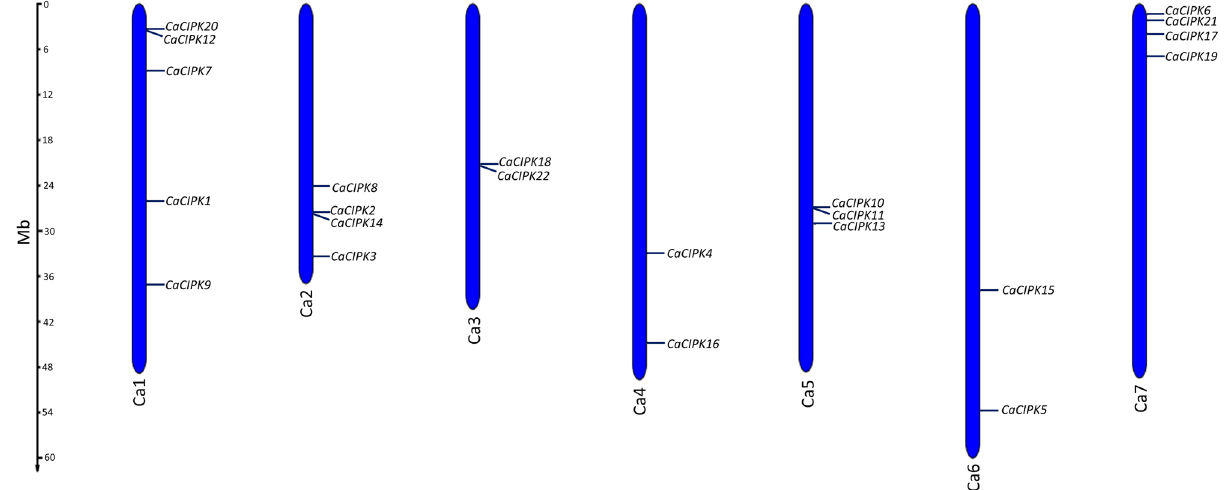
Figure 3. Chromosomal locations of chickpea CIPK genes. Blue colour bars represent the chromosomes, the location of genes has been marked alongside. Chromosome numbers are given at the bottom of each chromosome. Except chromosome 8, the CIPK genes are distributed variably on seven chromosomes.